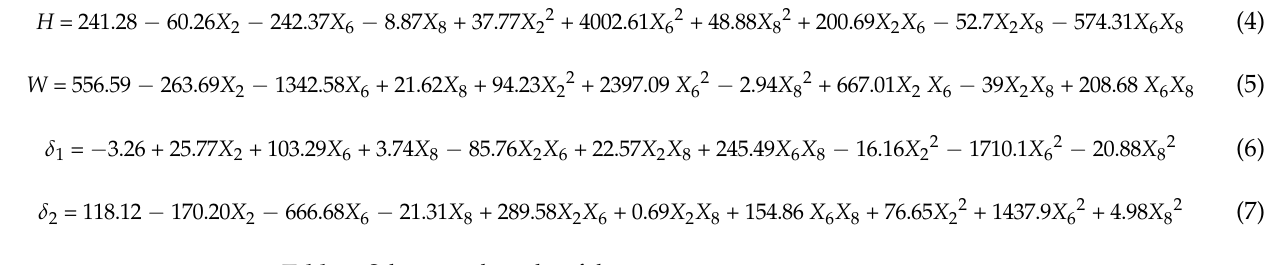
Table 6. Scheme and results of the